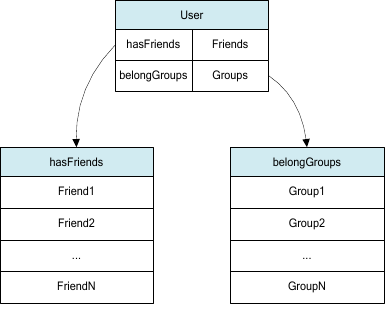
Fig 2. User Social Relationship